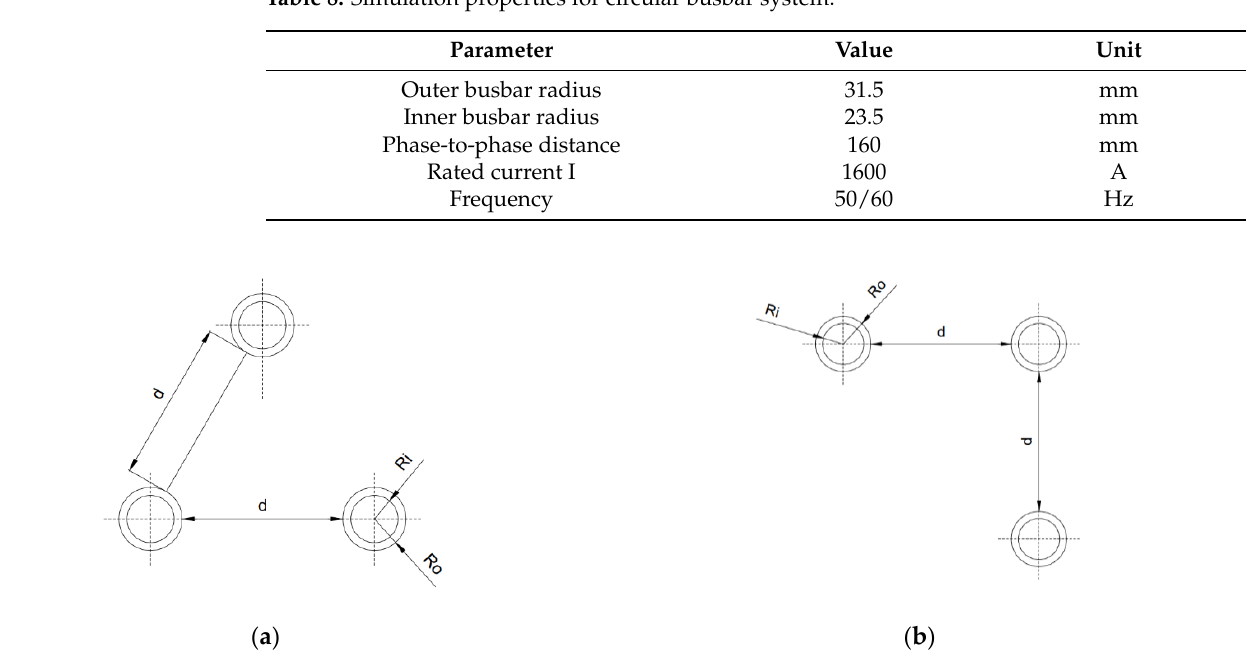
Figure 10. Layout of: ( a ) Model 5; ( b ) Model 6.